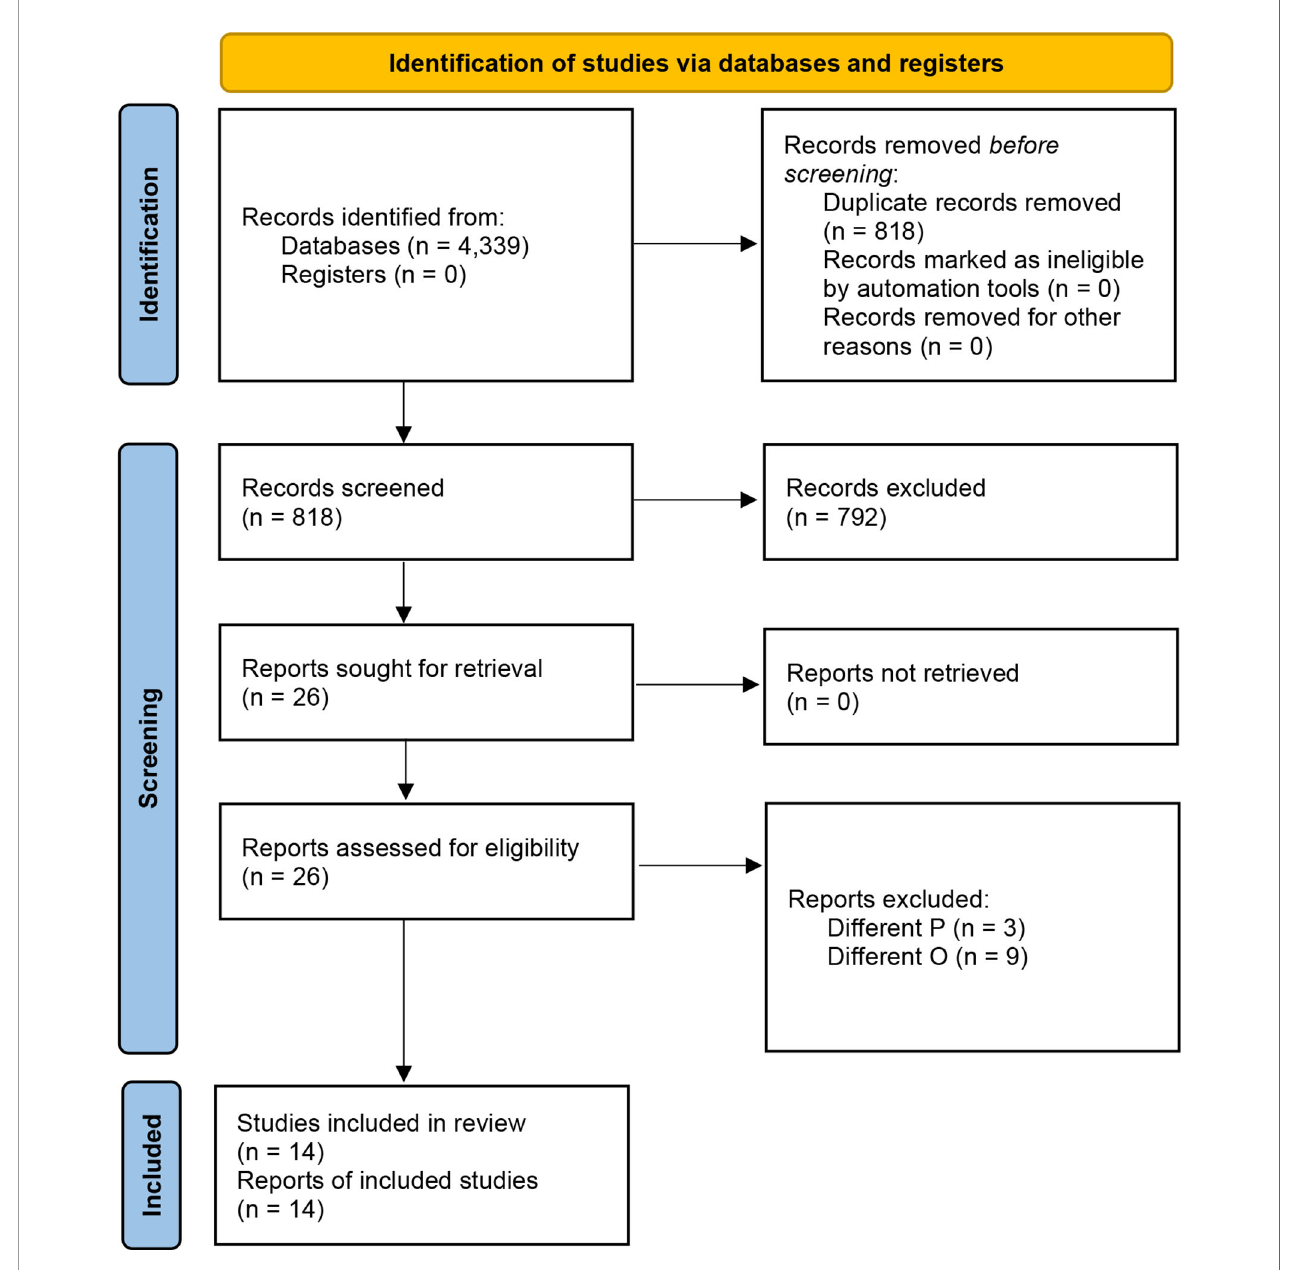
FIGURE 2 | The PRISMA fl